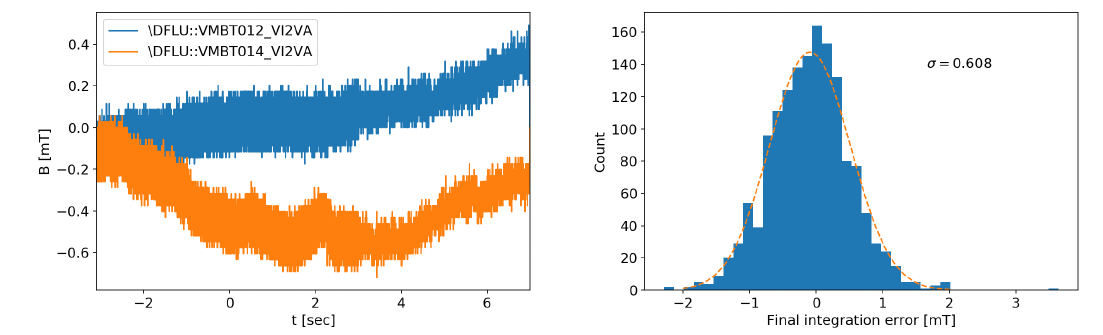
Figure 16. Examples of integrated signals ( left ) and distribution of final integration error of the analog integrators of RFX-mod after 10 s, from toroidal field sensors on eight “dry” pulses (1510 signals ( right